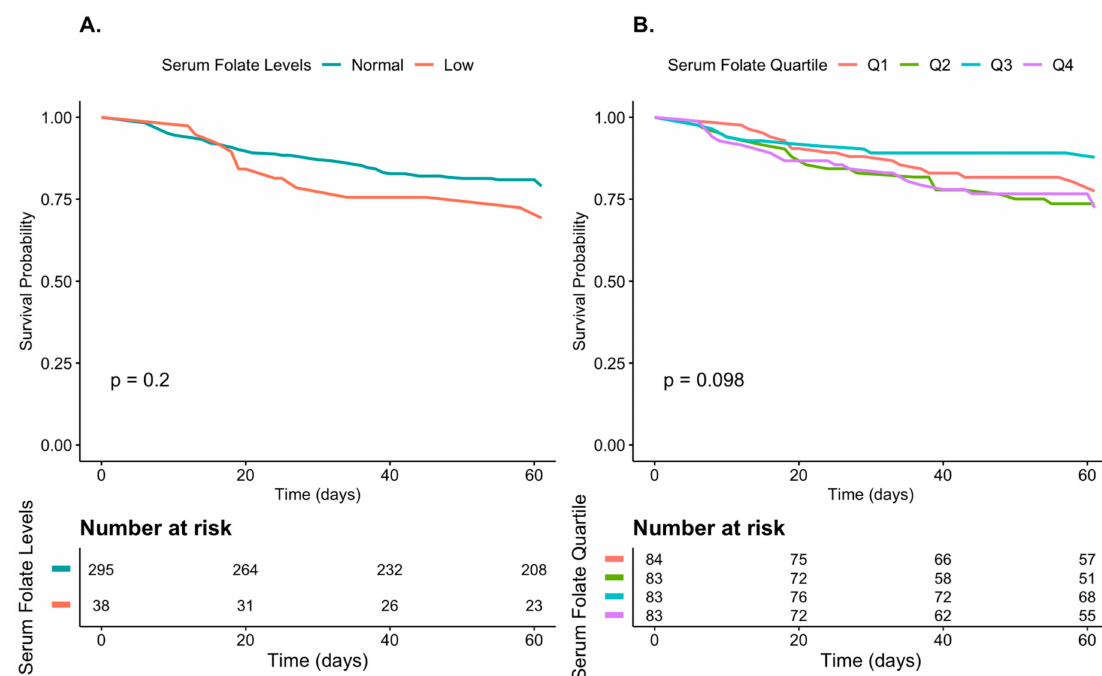
Figure 1. Kaplan-Meier survival curve in patients hospitalized with COVID-19. A. For normal-range and low folate levels B. For quartiles of the patients’ folate levels. No significant difference in the survival rate was observed between patients with decreased and those with normal-range folate levels ( A ) or according to quartiles of folate levels ( B ).